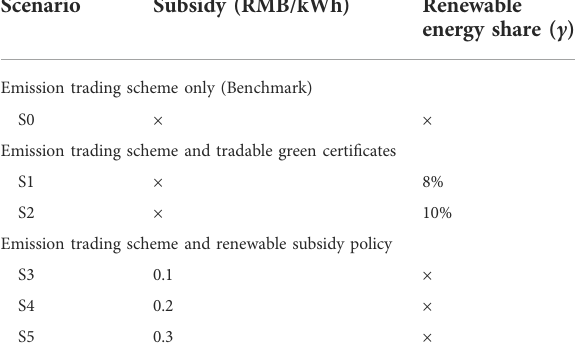
TABLE 2 Policy scenarios.